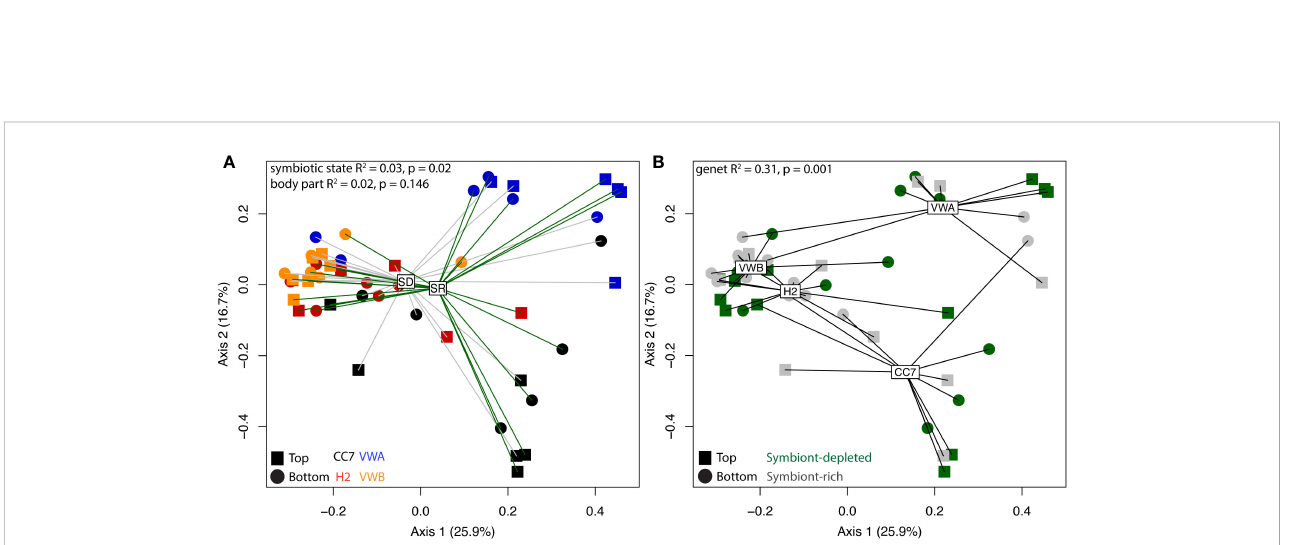
FIGURE 3 Principal coordinate analysis (PCoA) visualization using Bray-Curtis distances on abundance of ASVs between anemones. Spider-clustering groups samples by symbiont-depleted (SD) and symbiont-rich (SR) anemones (A) and genet (B) . Shapes represent body parts and colors represent genets, according to the inset legend. R-square and p-values were generated by permutational multivariate analysis of variance